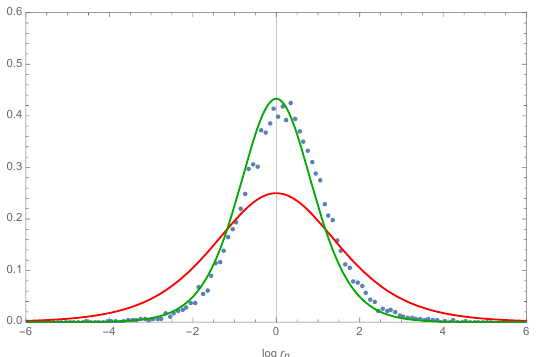
Figure 8. Distribution of log r n for the low lying states when (cid:0) = 5 : 0. There is no spin glass phase and thus even the low-lying states follow GOE statistics. The blue dots are numerical data, the red curve is for the exponential distribution, and the dark green curve is for the GOE